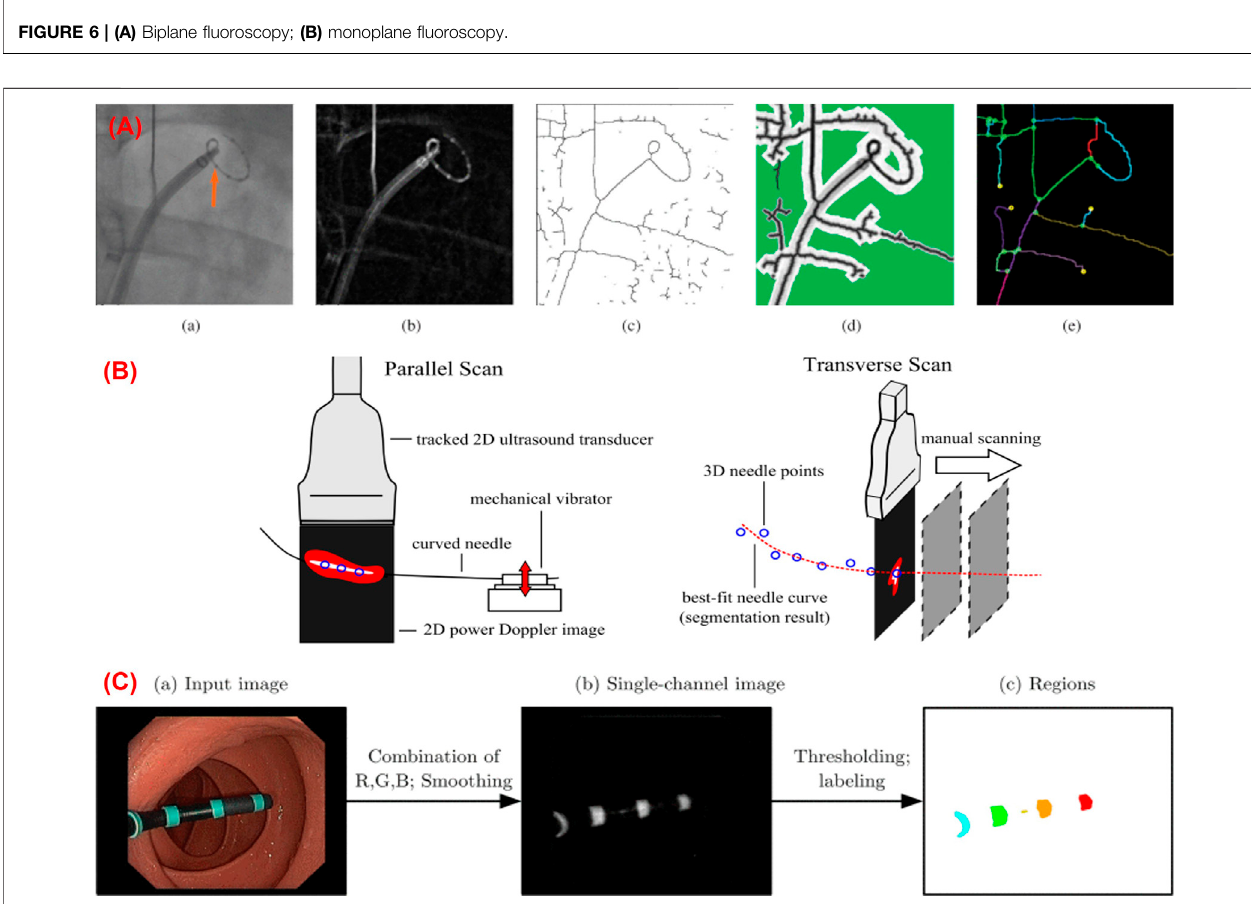
FIGURE7| (A) Shape sensing using biplane fl uoroscopyimages (Hoffmann et al., 2016); (B) 3D shape reconstruction ofacurved needle using ultrasound images (Greer et al., 2014); (C) Marker-based shape sensing using endoscopic camera images (Reilink et al., 2012).